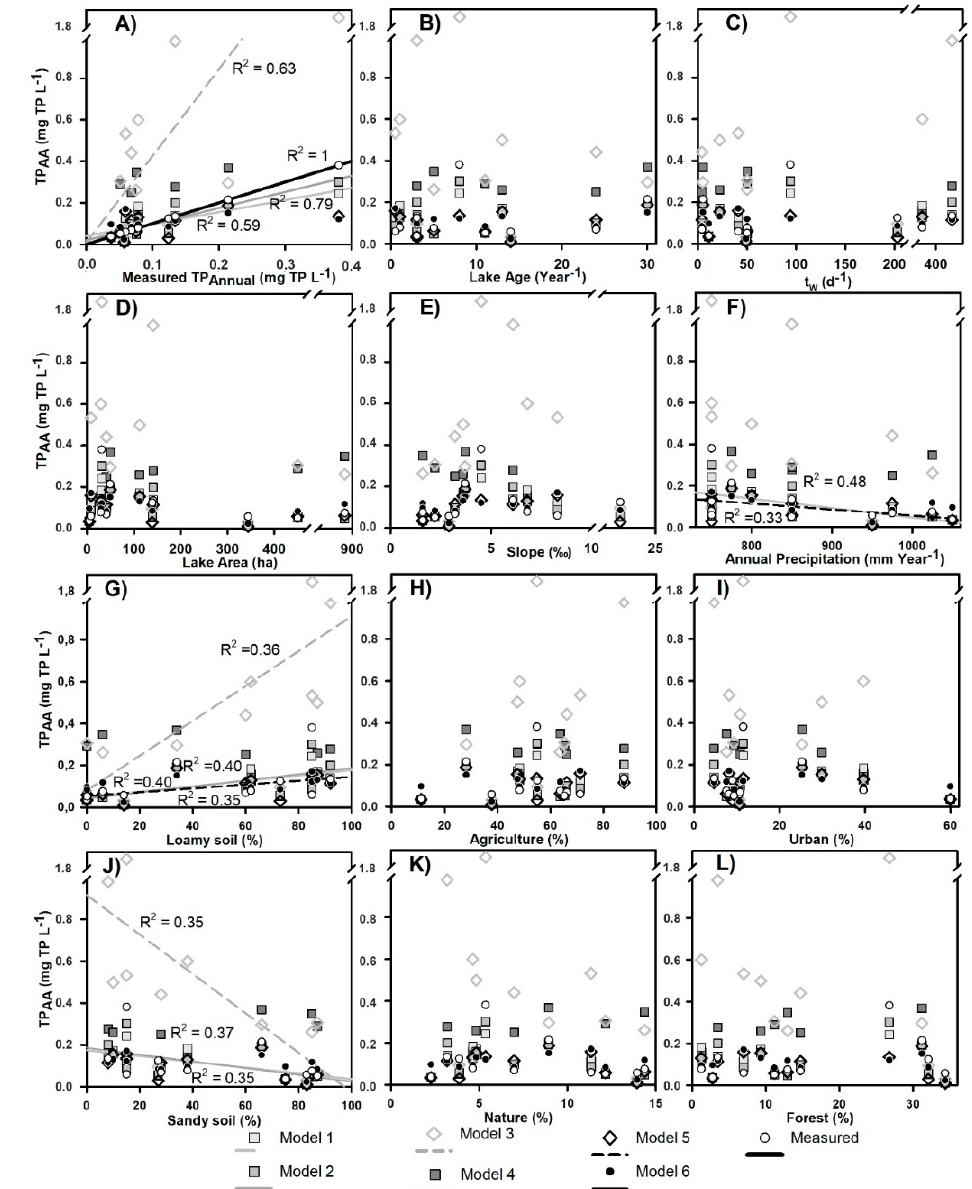
Figure 4. The measured TP Annual and modeled TP ModAnnual from the six methods as functions of lake and catchment characteristics. ( A ) TP ModAnnual as a function of the measured TP Annual concentration. ( B ) TP ModAnnual as a function of lake age. ( C ) TP ModAnnual as a function of hydrological residence time (t W ). ( D ) TP ModAnnual as a function of the lake surface area. ( E ) TP ModAnnual as a function of the catchment slope. ( F ) TP ModAnnual as a function of the average annual precipitation. ( G ) TP ModAnnual as a function of the catchment cover of loamy soil. ( H ) TP ModAnnual as a function of the catchment cover of agriculture. ( I ) TP ModAnnual as a function of the catchment cover of urban. ( J ) TP ModAnnual as a function of the catchment cover of sandy soil types. ( K ) TP ModAnnual as a function of the catchment cover of nature. ( L ) TP ModAnnual as a function of the catchment with forest cover. All significant regressions are shown, and R 2 -values stated ( p < 0.05); all regressions can be found in Supplementary